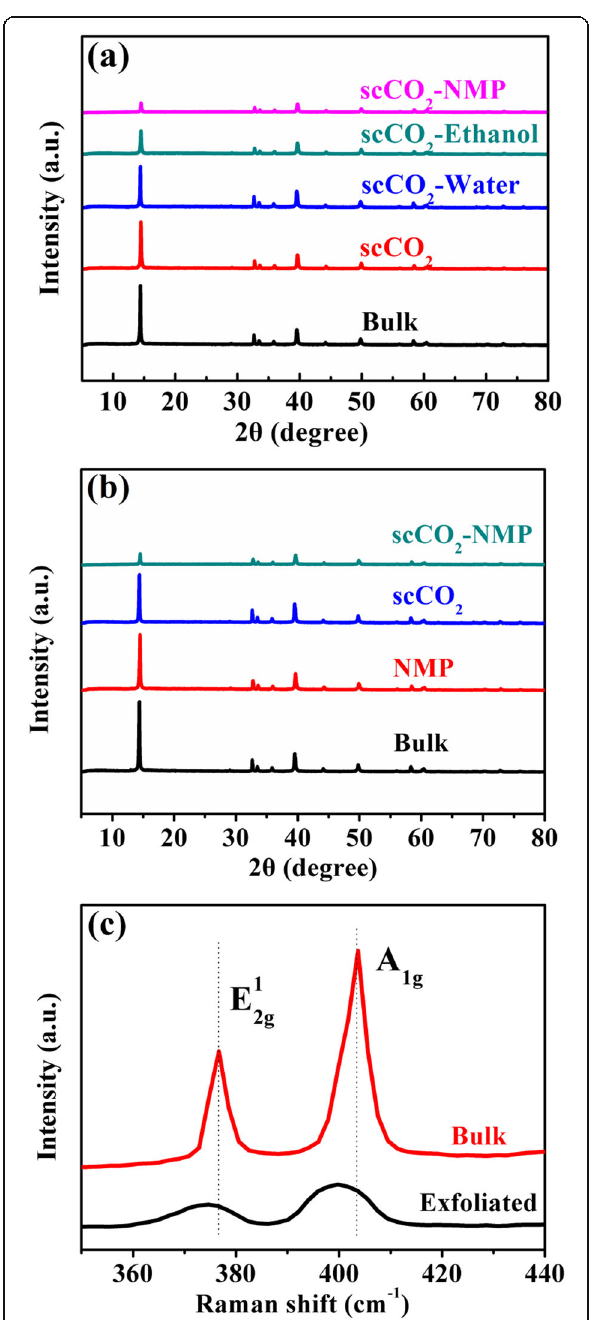
Fig. 2 a The XRD patterns of the exfoliated MoS 2 from different co- solvents of NMP, ethanol, and water with supercritical CO 2 , respectively, as compared to the result from when supercritical CO 2 is used as the only solvent and to that of the bulk sample. b The XRD patterns of the exfoliated MoS 2 under conditions of NMP and supercritical CO 2 used individually compared to used together to show the synergistic effect. c Raman spectroscopy of the bulk and MoS 2 exfoliated from the complex solvent of NMP and supercritical CO